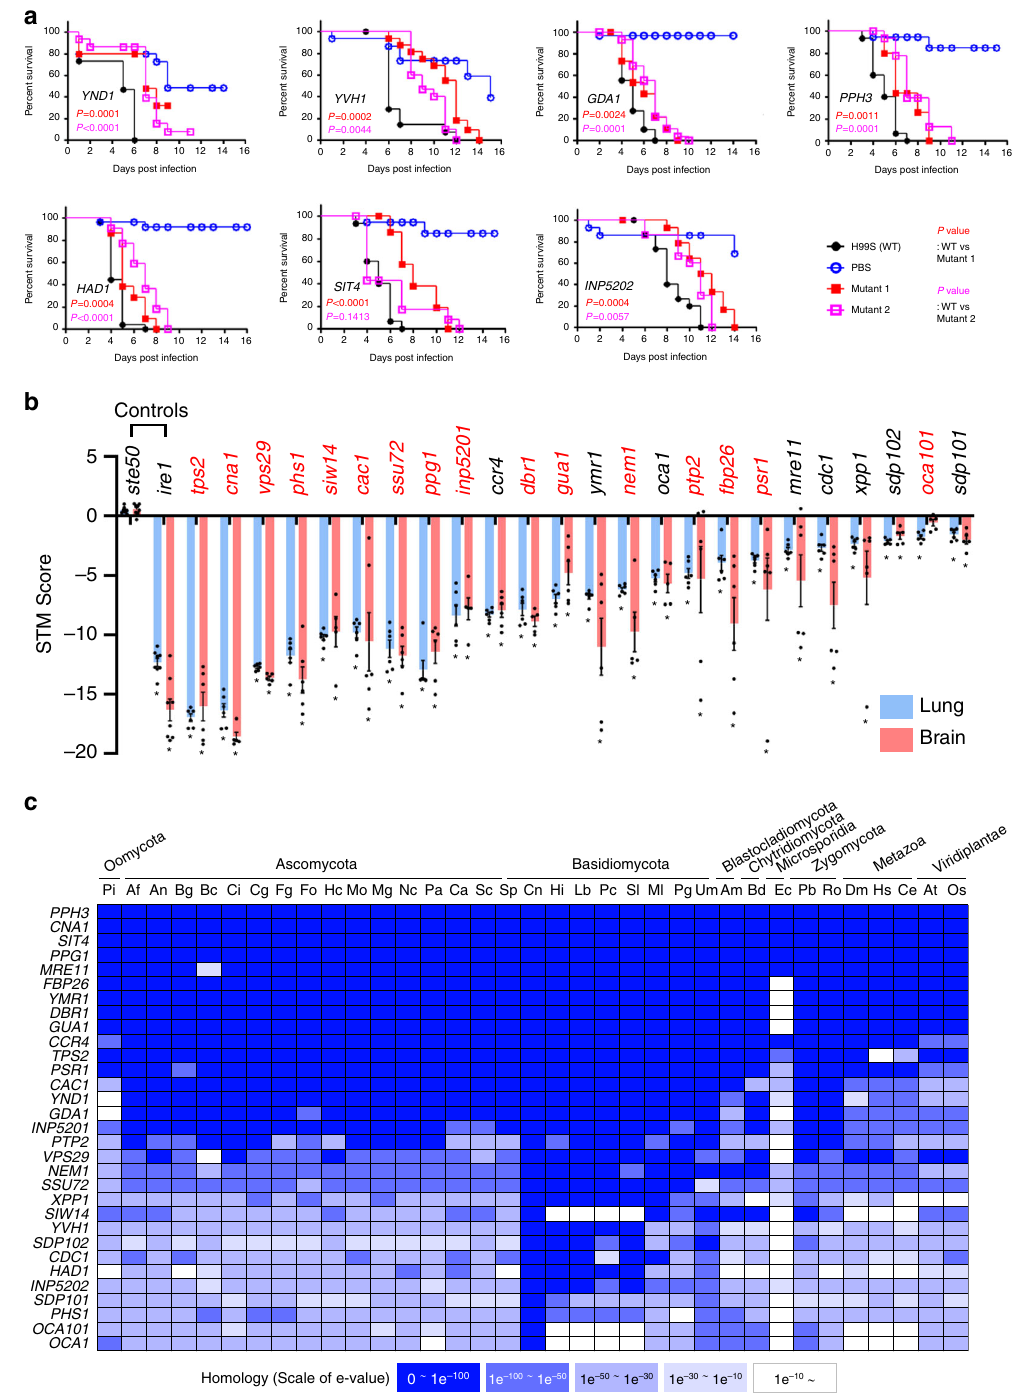
from the lungs to other organs during early infection, phosphatase transcripts can be detected 3 – 7 dpi. Phosphatases governing C. neoformans pathogenicity . To identify phosphatases required for the pathogenicity of C. neo- formans , we performed two large-scale infectivity and virulence assays: (1) a virulence assay using the insect larval model system Galleria mellonella and (2) signature-tagged mutagenesis (STM)- based lung and brain infectivity assays using a murine inhalation model. Both methods have been successfully used for identifying